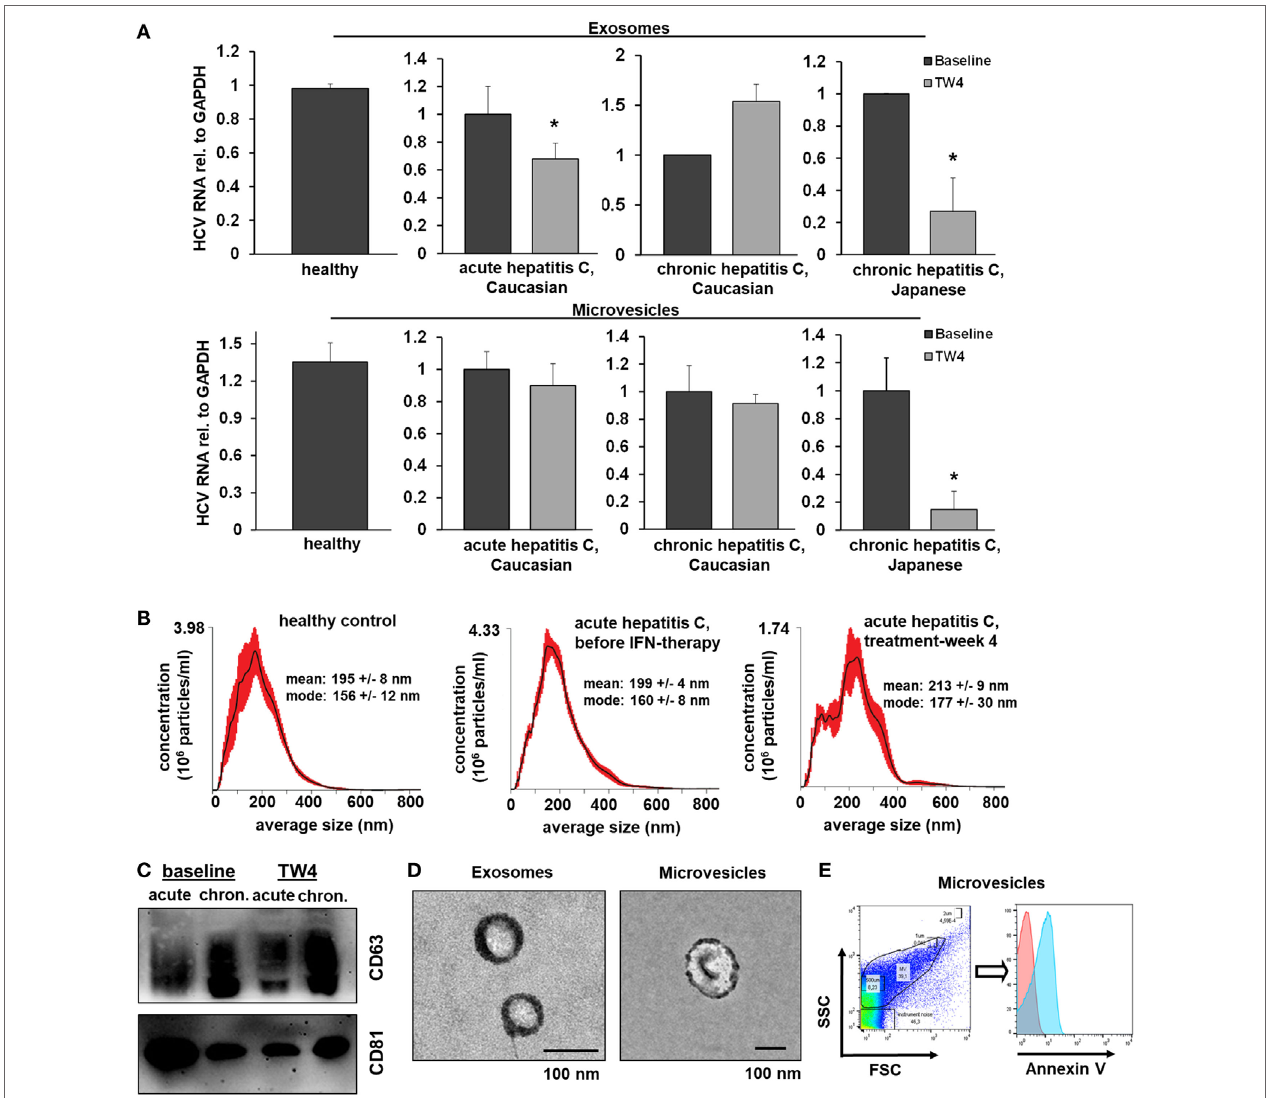
FigUre 7 | Extracellular vesicles (EVs) from patients with hepatitis C who are treated with PEG-IFN- α -based therapy inhibit hepatitis C virus (HCV) replication in vitro . (a) Exosomes (upper panel) and microvesicles (lower panel) were isolated from serum of healthy Caucasian donors or of Caucasian or Japanese patients with acute or chronic hepatitis C before and at treatment week 4 (TW4) of PEG-IFN- α -based antiviral therapy and transferred to human hepatoma cell lines harboring subgenomic HCV replicons. HCV RNA was quantified by quantitative PCR. Combined data of two independent experiments comprising EVs from three independent patients each are shown. Data are normalized to the baseline patients. (B) EV concentration and size distribution analysis of serum samples of patients with acute hepatitis C compared with healthy controls. (c) Western blot analysis of EV markers of patients with acute and chronic hepatitis C before and during antiviral therapy. (D) Electron microscopy of exosomes and microvesicles isolated from serum from a healthy control. (e) Representative scatter blot and Annexin V staining of microvesicles isolated from a healthy control mixed with calibration beads, as analyzed by flow cytometry (red-unstained, blue-Annexin V positive) (* P <